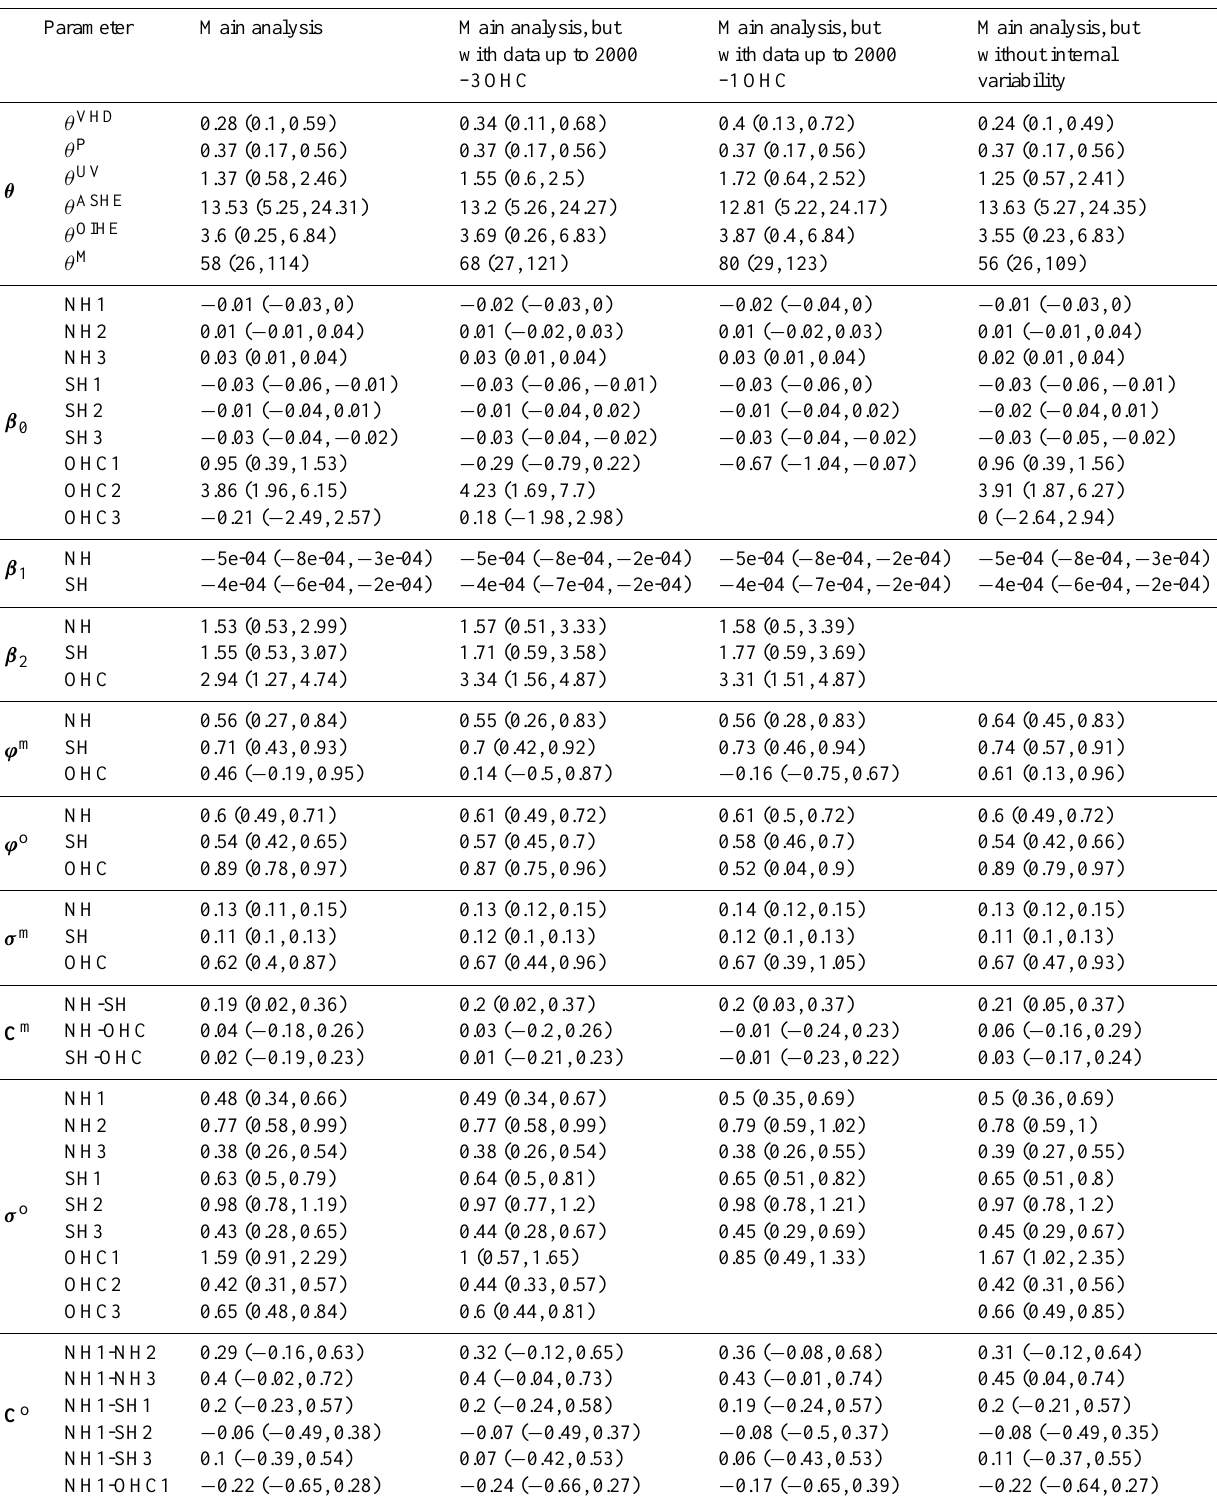
Table A3. Parameter estimates with 95%C.I. In the table ϕ m and ϕ o are the diagonal coefficient matrices of the VAR(1) processes for the model and observational errors, respectively, and σ m / C m and σ o / C o are the standard deviations/correlation matrices of the covariance matrix 6 m and 6 o of the error terms of the VAR(1) processes for the model and observational errors, respectively, i.e. 6 m =diag( σ m ) C m diag( σ m ) and 6 o =diag( σ o ) C o diag( σ o ). For each analysis there are at least 140million iterations after burn-in in the MCMC estimation